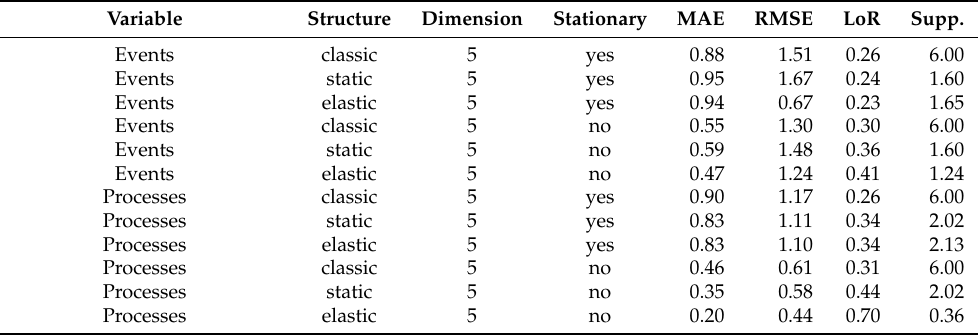
Table 3. Comparison of the Markov chain model prediction performances in terms of MAE [min], RMSE [min], LoR [%], and inner support [min] for a state space dimension of five. Variable Structure Dimension Stationary MAE RMSE Supp.